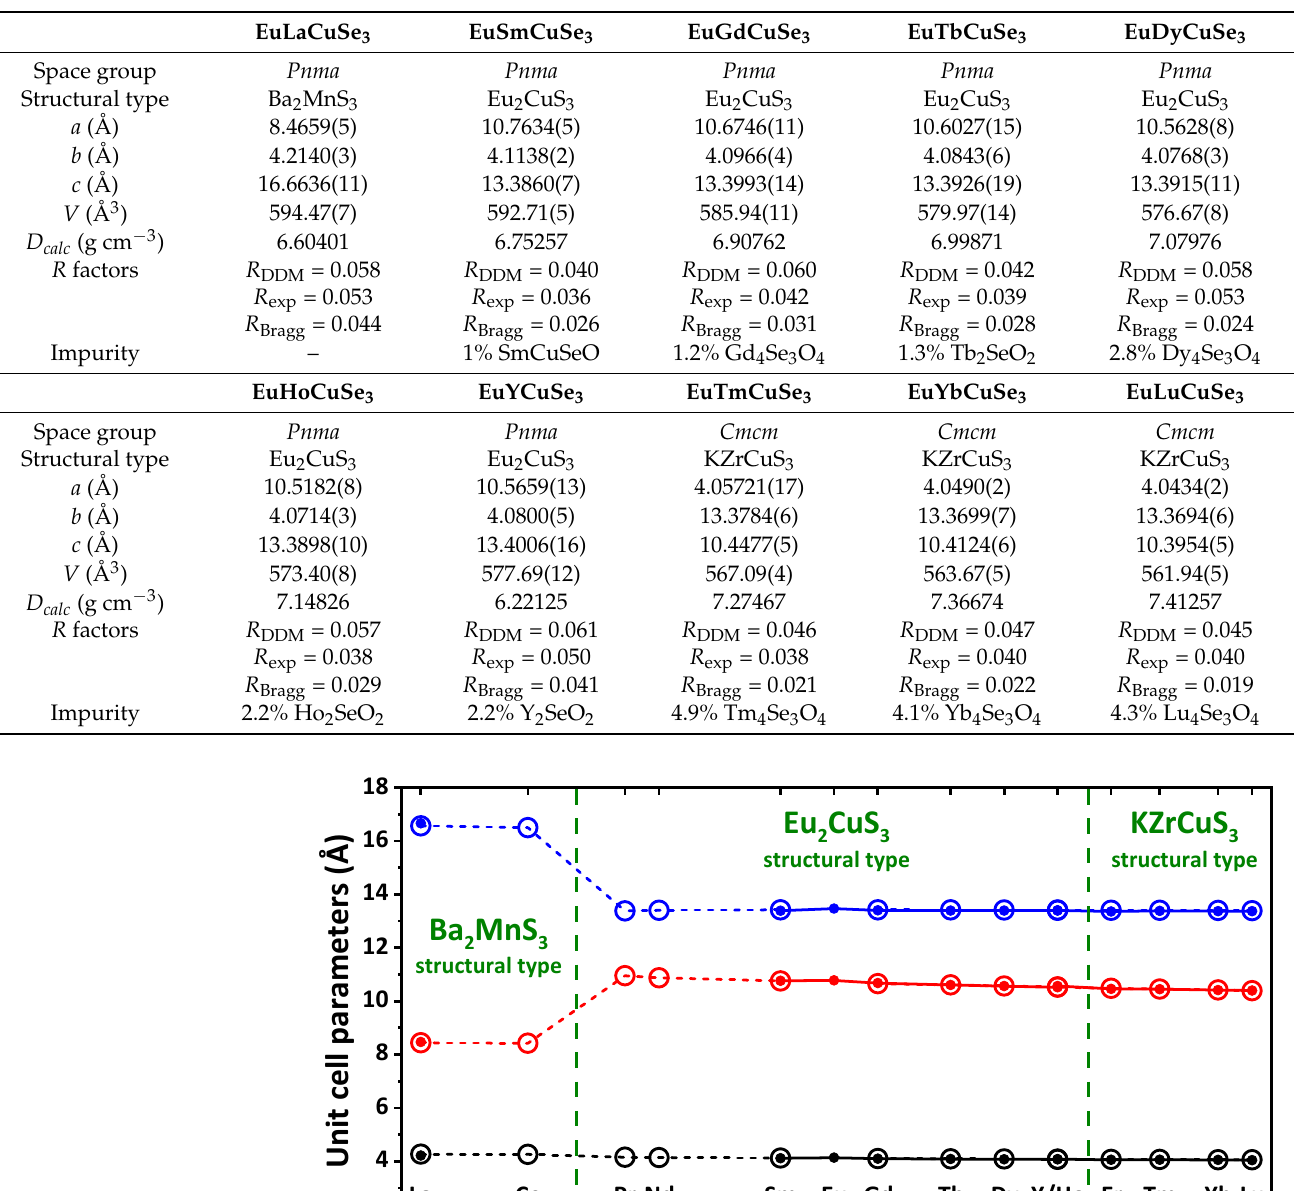
Table 1. Experimental details for the structures of EuLnCuSe 3 (Ln = La, Sm, Gd, Tb, Dy, Ho, Y, Tm, Yb, Lu).